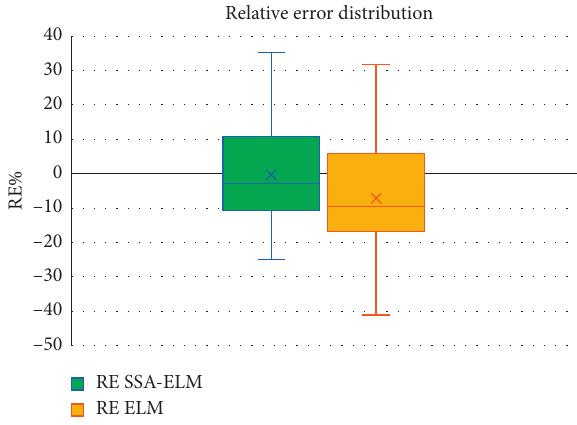
Figure 9: Relative error distribution percentage of SSA-ELM and ELM